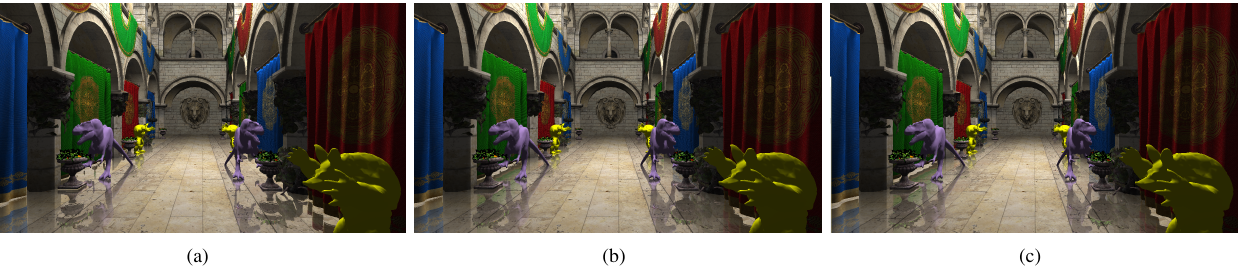
Fig. 13. Visual quality comparisons of the animation rendered using the (a) SSR technique, (b) our hybrid solution and (c) ray tracing from the deformable